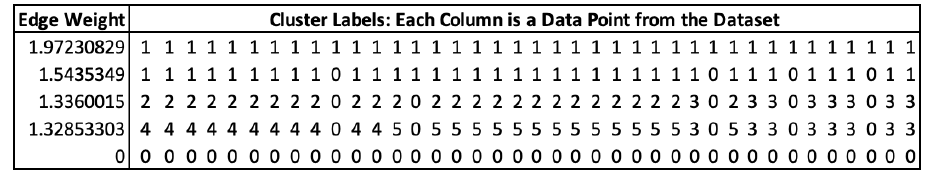
Figure 4. A tablular representation of the HDBSCAN* hierarchy of the simple